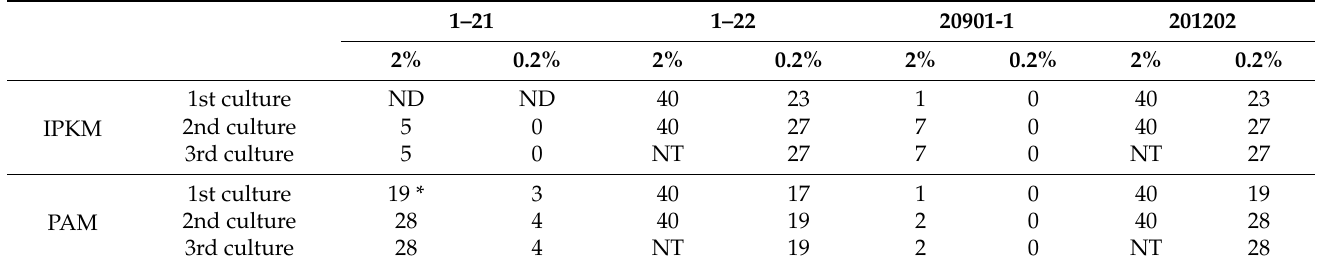
Table 2. Number of wells showing HAD in PAM and IPKM cells inoculated with 2 and 0.2% sausage homogenates (Lot